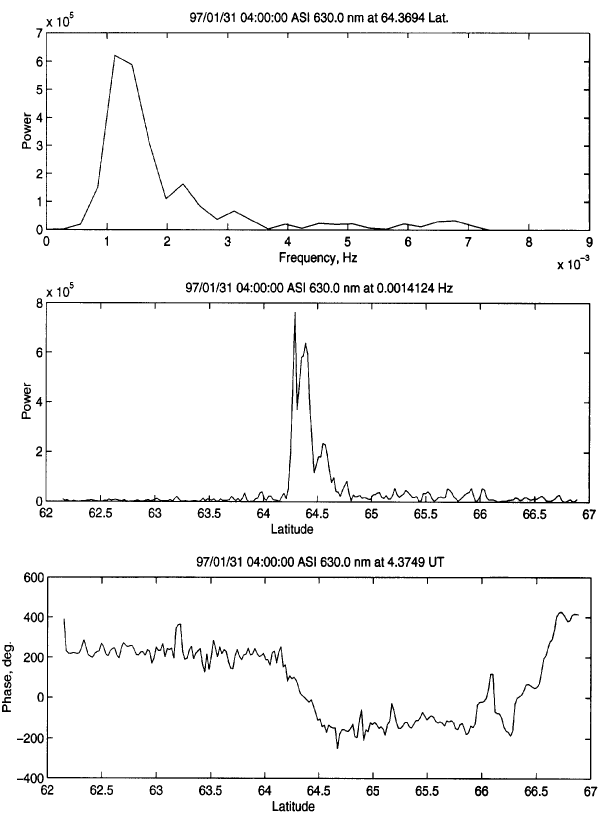
Fig. 9. Power and phase as a function of latitude for the 1.3mHz spectra of ASI, 630.0nm luminosities recorded at a longitude of 337